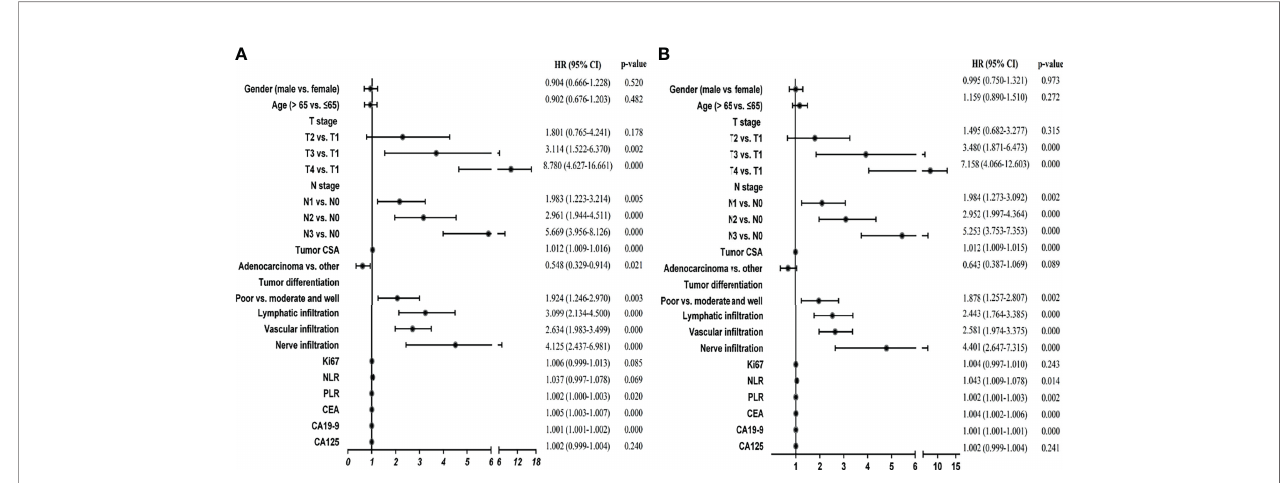
FIGURE 1 | Univariate Cox regression analyses of stage I-III GC patients in the training cohort. (A) Univariate Cox regression analyses for DFS. (B) Univariate Cox regression analyses for